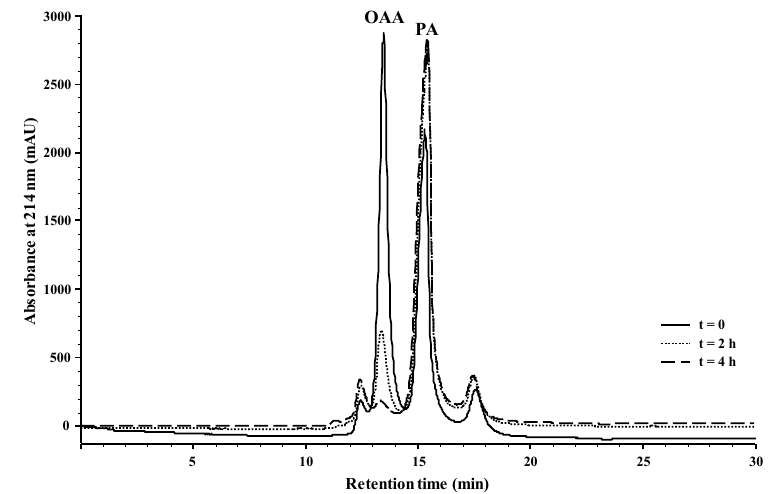
Figure 5. HPLC chromatograms recorded at 511 nm of a model solution (pH 3.5) containing the wine anthocyanins 3-monoglucoside dp-3-glc, pt-3-glc, pn-3-glc, and mv-3-glc (1.9 mM), PA (9.5 mM), and OAA (9.5 mM) at pH 3.5 at time 0, 2, and 4 h at room temperature.